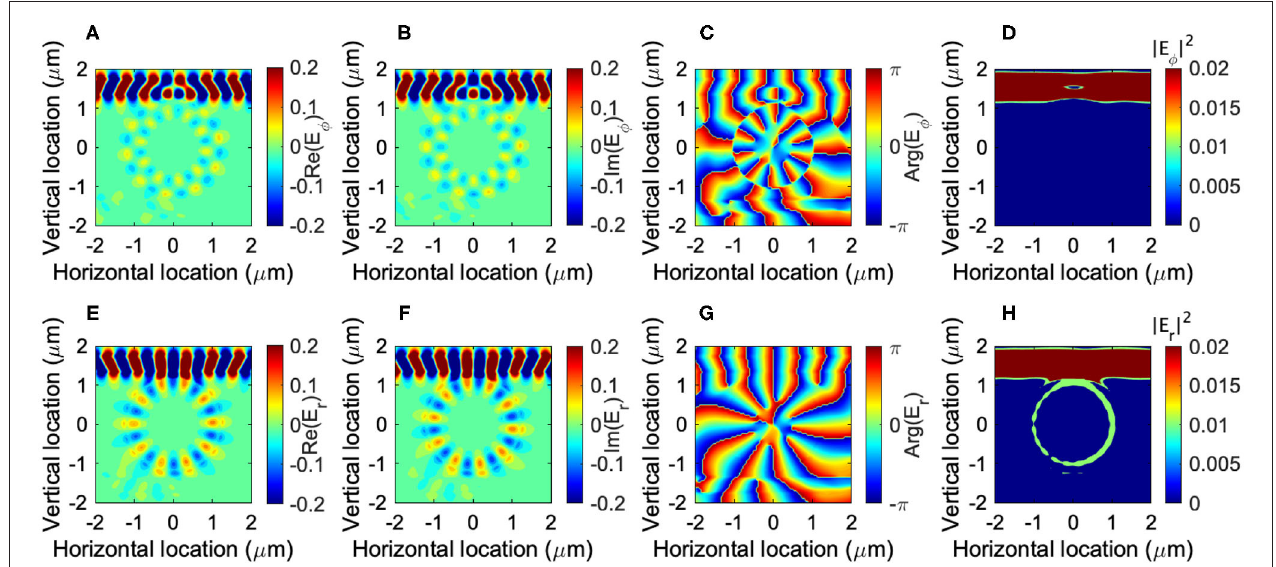
FIGURE 2 | Ring resonator coupled to a wire waveguide. (A) Real and (B) imaginary part of the azimuthal component of the electric field, its (C) phase, and (D) intensity. (E) Real and (F) imaginary part of the radial component of the electric field, its (G) phase, and (H) intensity. The orbital angular momentum of m obtained for a ring of the radius of 1 µ m at the wavelength of 1,540 nm. The mode is rotating along the clock-wise (right)